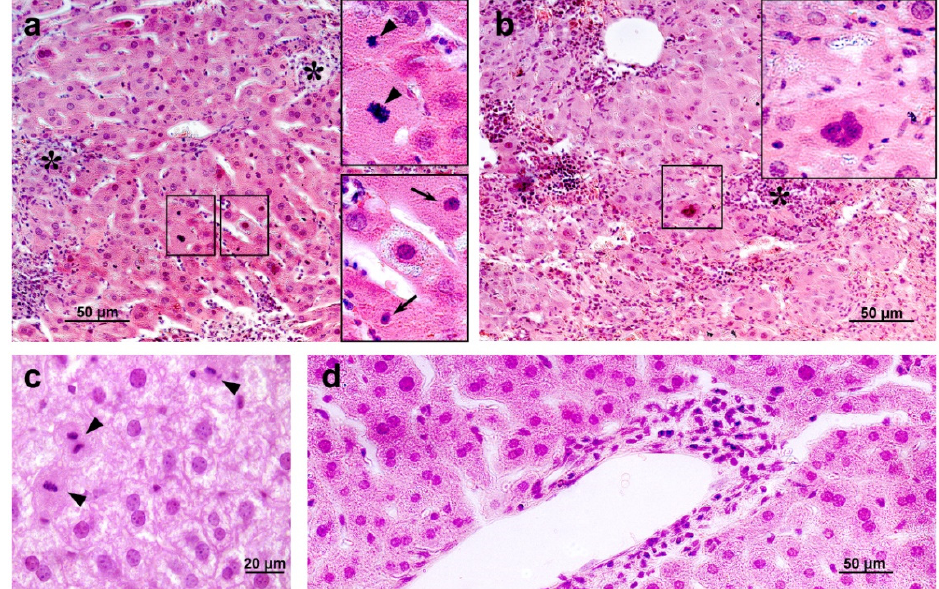
Figure 14. The histological changes in mouse liver after 7.5 Gy whole-body gamma irradiation: necrosis (( a , b ), asterisks), pyknotic nuclei (( a ), arrows), numerous mitoses (( a , c ), arrow heads), vacuolar dystrophy of hepatocytes ( c ), mononuclear infiltration ( d ). Megakaryocyte ( b ). Representative photomicrographs of liver sections (groups: IR, IR+Lf, IR+Lf×2). Hematoxylin and Eosin staining. Scale bars = 50 μ m and 20 μ m.